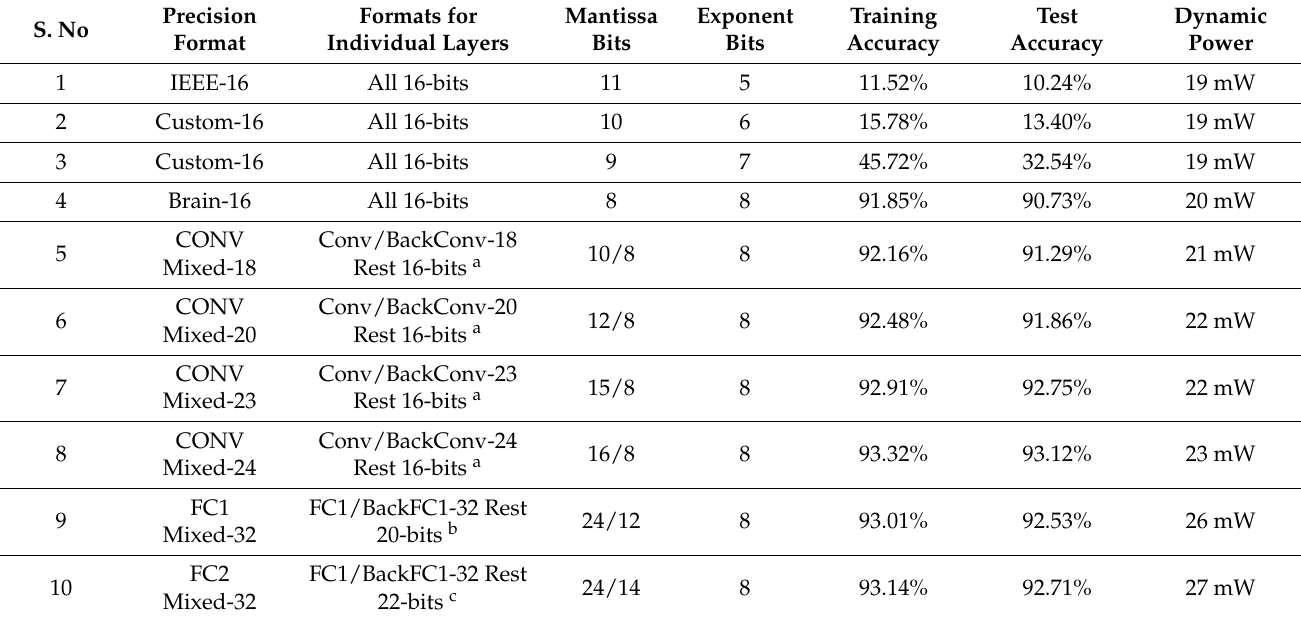
Table 7. Comparison of accuracy and dynamic power using the algorithm.